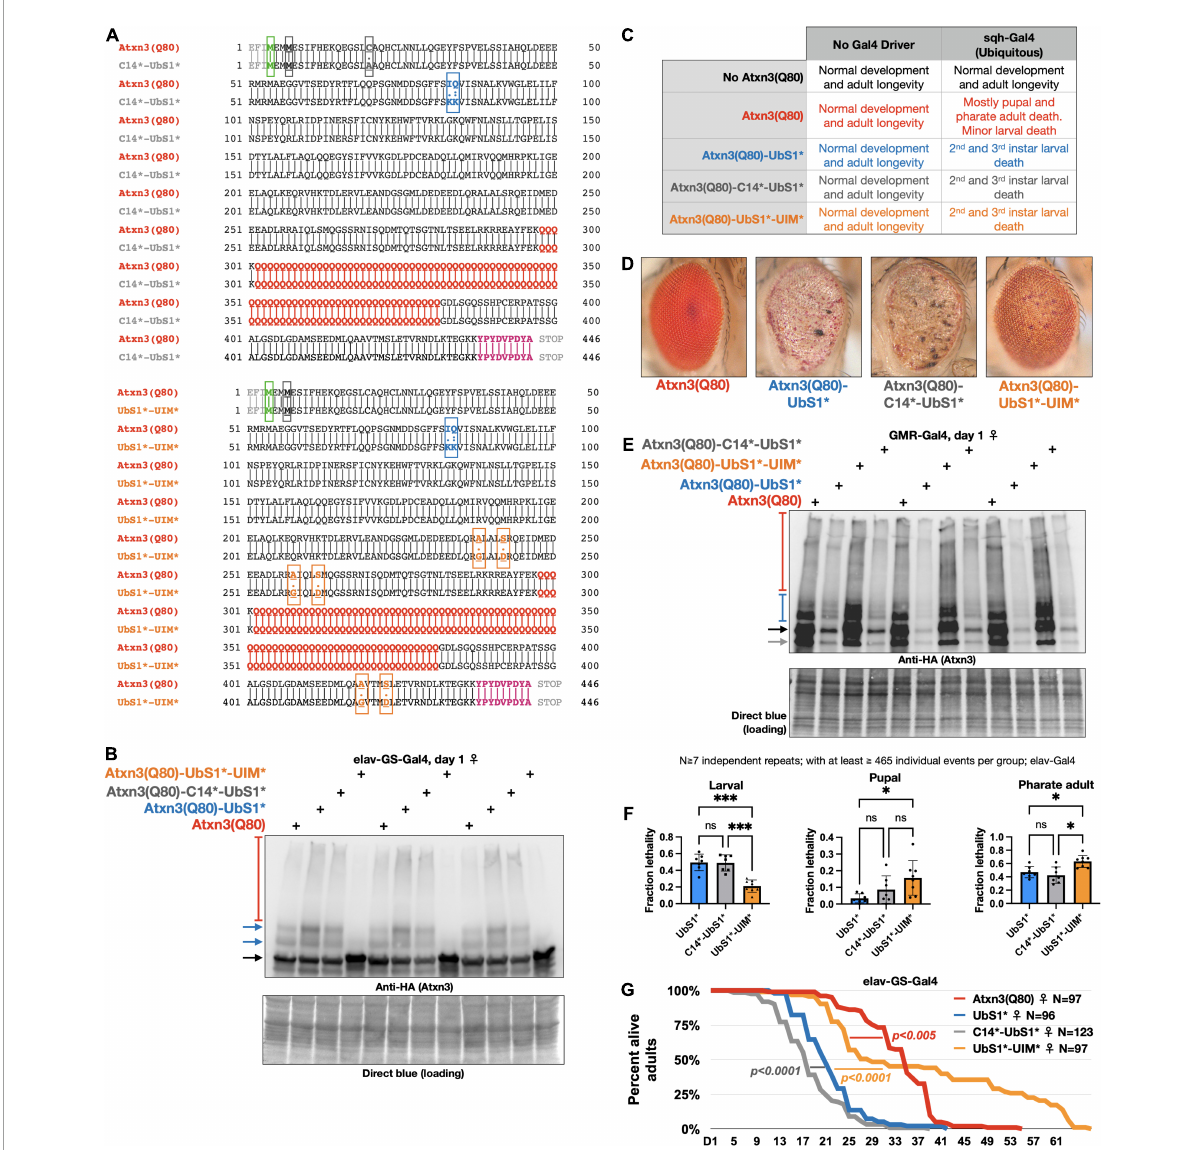
FIGURE5 Effect of catalytic cysteine mutation and UIM mutations on toxicity from UbS1 ∗ . (A) Amino acid sequences of the transgenic Atxn3 expressed in the new lines that we generated. Highlighted: First methionine (green), endogenous methionine (black); C14 mutation (gray); UbS1 mutation (blue); polyQ tract (red); UIM mutations (orange); HA epitope tag (purple). (B) Western blots of flies expressing the noted versions of Atxn3 in adult neurons for 1 day. Each lane is an independent repeat. Black arrow, main Atxn3 band. Blue arrows, ubiquitinated Atxn3. Red bracketed bar, SDS-resistant Atxn3. (C) Summary of results when the noted versions of Atxn3 are expressed in all tissues. (D) Representative photographs of external eyes expressing the noted versions of Atxn3. Flies were 1 day old. (E) Western blots from expression of the noted versions of Atxn3 in fly eyes. Flies were 1 day old. Each lane is an independent repeat. Black arrow, main Atxn3 band. Blue bracketed bar, ubiquitinated Atxn3. Red bracketed bar: SDS-resistant species of Atxn3. Gray arrow: Proteolytic fragment we observe sometimes. Reduced Atxn3 signal intensity in the lanes with UbS1 ∗ and C14 ∗ -UbS1 ∗ mutations are from loss of eye mass due to degeneration. (F) Summary of results when the noted versions of Atxn3 are expressed in all neurons, throughout development (elav-Gal4). “ns”, not significant. ∗ p < 0.05, ∗∗∗ p < 0.001. Statistics: Brown-Forsythe and Welch ANOVA tests. (G) Longevity of flies expressing the noted versions of Atxn3(Q80) in all adult neurons (elav-GS-Gal4). P -values: log-rank